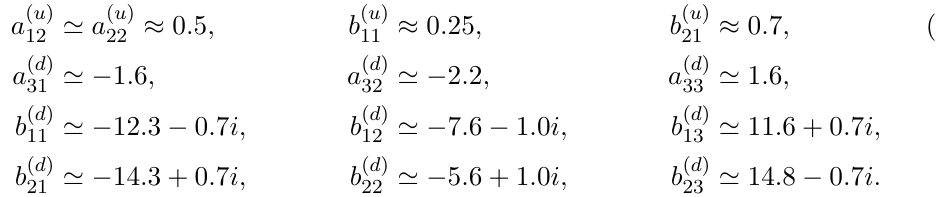
and in the internal lines correspond (cid:2) (cid:10)